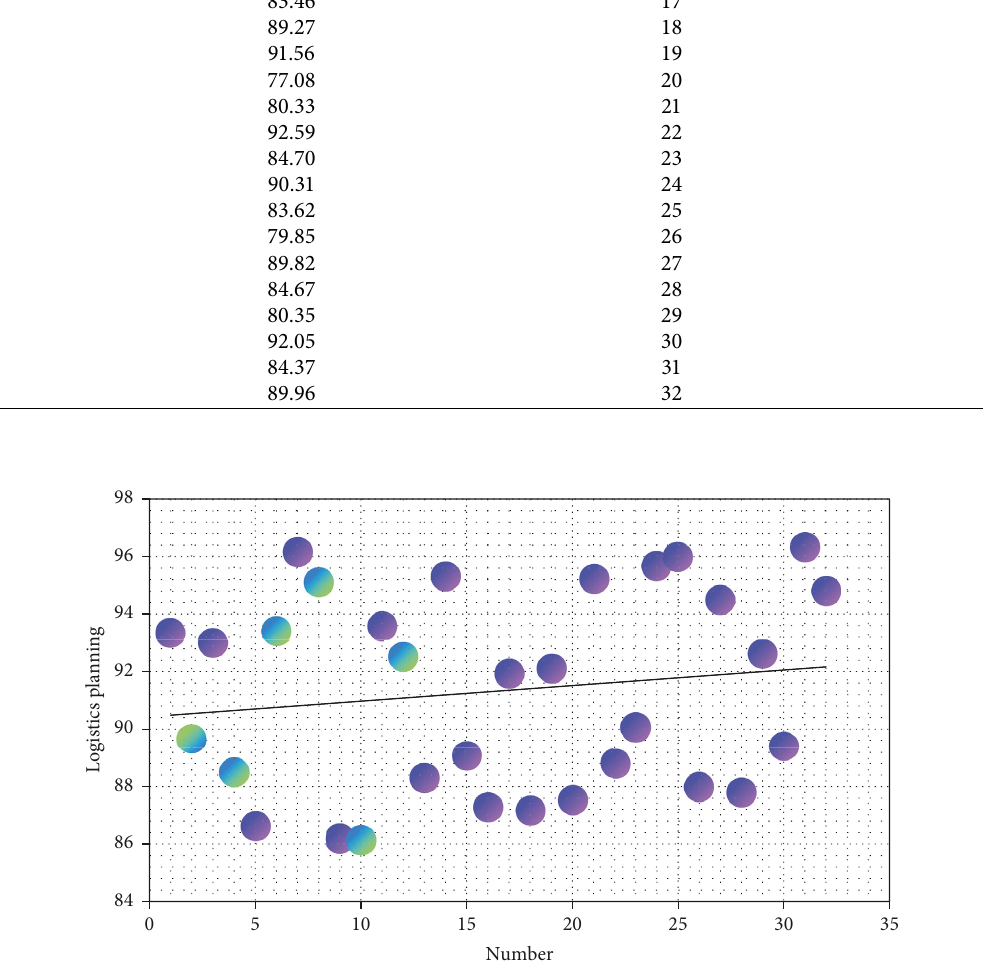
Figure 11: Statistical diagram of logistics planning performance.